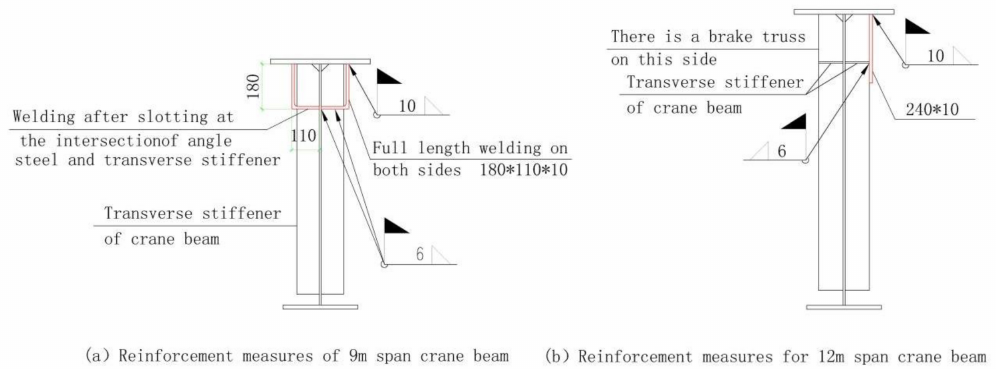
Figure 7. Reinforcement measures for crane